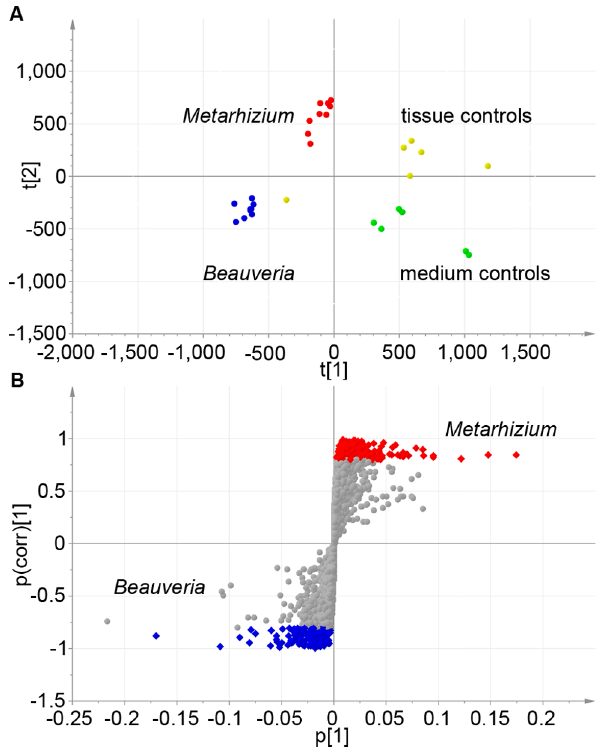
Figure 1. Separate clustering of fungal and control samples used in this study. A) Principle Component Analysis (PCA) of samples incubated in Schneider’s medium supplemented with 10% FBS. Clustering of different sample types based on all samples for medium controls (green), ant brain and muscle controls (yellow), Beauveria growth (blue), and Metarhizium growth (red) in a three-dimensional score space. B) S-plot analysis of all Metarhizium samples against all Beauveria samples. All Metarhizium related ions with p(corr) [1] . 0.8 are marked red, while all Beauveria related ions with p(corr) [1] . 0.8 are marked